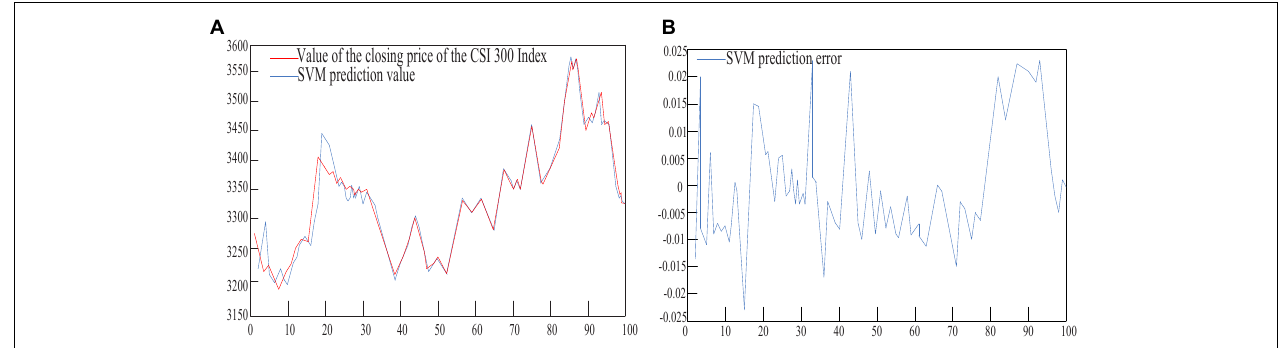
FIGURE 8 | Support vector machine model testing. (A) Is a simulation diagram of the test results of the support vector machine model. (B) Shows the error of the test results of the support vector machine model.